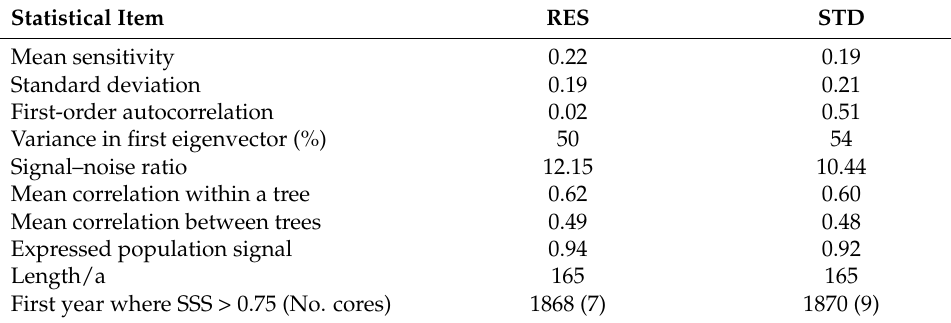
Table 2. Summary of statistics for Larix chinensis tree-ring residual chronology (RES) and standard chronology (STD) of Mt.